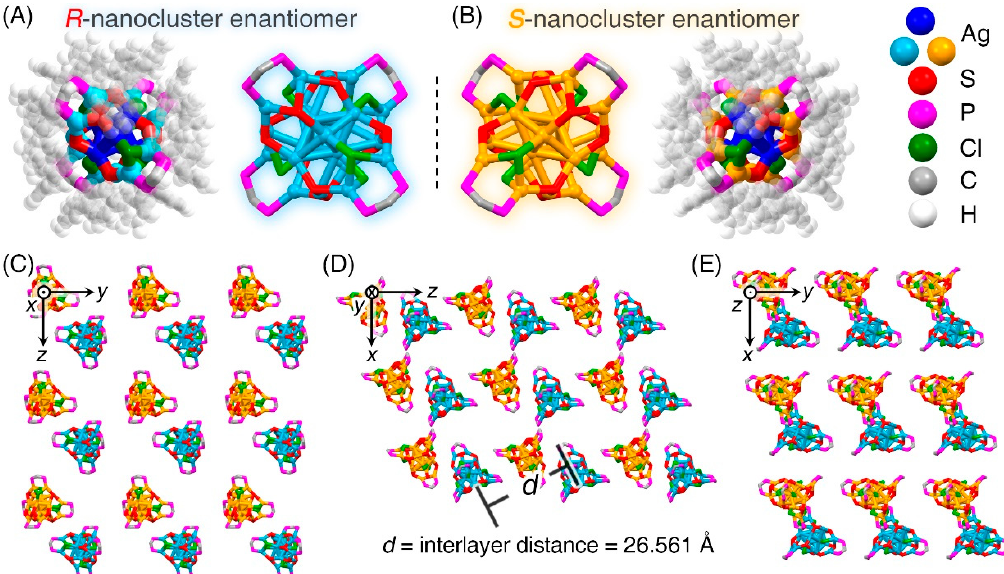
Figure 3. Crystalline packing of the Ag 22 -L1 nanocluster molecules. ( A ) Structure of the R -nanocluster enantiomer. ( B ) Structure of the S -nanocluster enantiomer. ( C – E ) Packing of the Ag 22 -L1 molecules in the crystal lattice: view from the x axis ( C ), y axis ( D ), and z axis ( E ). The inter-layer distance along with the z axis is 25.561 Å. Color codes: blue/light blue sphere, Ag in R -nanocluster enantiomer; blue/orange sphere, Ag in S -nanocluster enantiomer; red sphere, S; magenta sphere, P; green sphere, Cl; grey sphere, C; white sphere, H.